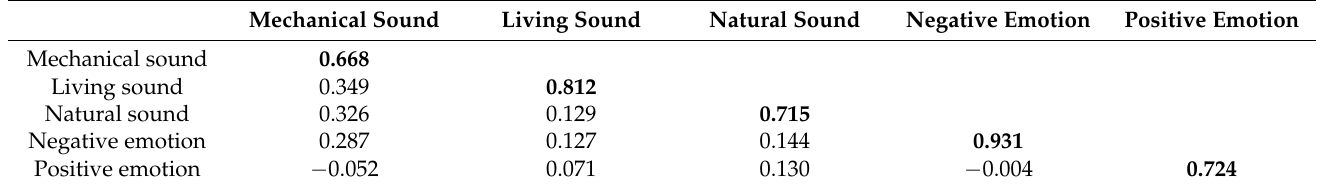
Table 5. Discriminant validity measurements.